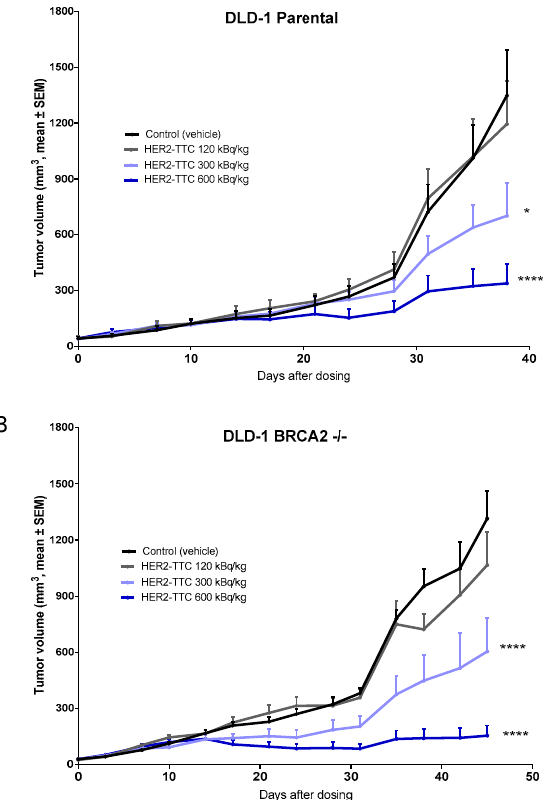
Figure 4. In vivo e ffi cacy of single treatment with HER2-TTC in DLD-1 parental xenograft and DLD-1 BRCA2 - / - xenograft. ( A ) Tumor size determined after a single dose administration of HER2-TTC (120, 300, or 600 kBq / kg bw, 0.14 mg / kg bw, i.v.) as compared to vehicle in DLD-1 parental and ( B ) tumor size determined after a single dose administration of HER2-TTC (120, 300, or 600 kBq / kg bw, 0.14 mg / kg bw, i.v.) as compared to vehicle in DLD-1 BRCA2 - /